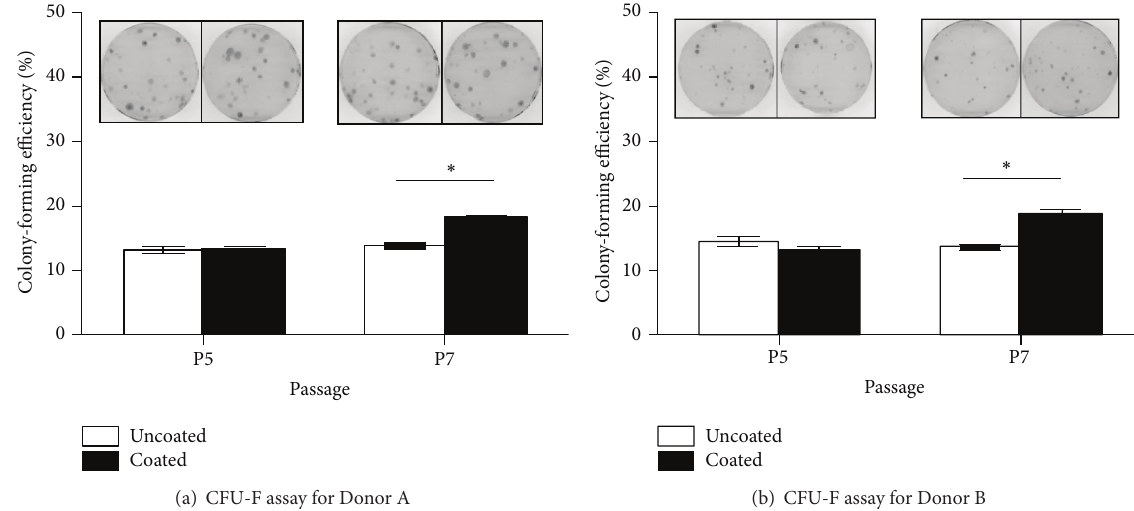
Figure 5: Colony-forming efficiencies of (a) Donor A and (b) Donor B hMSCs after being expanded on either uncoated or keratin-coated TCPS for 1 passage (P4 to P5, assessed at P5) and 3 passages (P4 to P7, assessed at P7). Corresponding micrographs above the bar charts depict representative hMSC colonies stained with crystal violet; 𝑛 = 6 , ∗ 𝑃 < 0.05